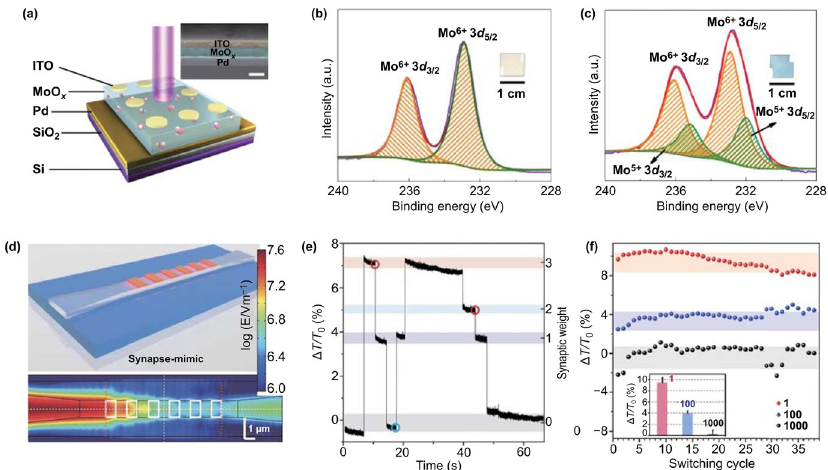
Fig. 7 a Schematic of MoO x -based device. b Narrow scans of the Mo 3d peak for the MoOx layer before UV illumination. c Narrow scans of the Mo 3d peak for the MoOx layer after UV illumination. a – c Reproduced with permission from Ref. [17]. d Top: Photonic synapse with syn- apse-mimic design: a tapered waveguide with six discrete Ge 2 Sb 2 Te 5 (GST) islands (1 mm × 0.8 mm each). e Change of synaptic weight in the device during switching with the relative transmission change (ΔT/T 0 ) recorded. f Cycle-to-cycle weight changes. The inset: Statistical analysis of different weights at different pulse numbers. d – f Reproduced with permission from Ref.